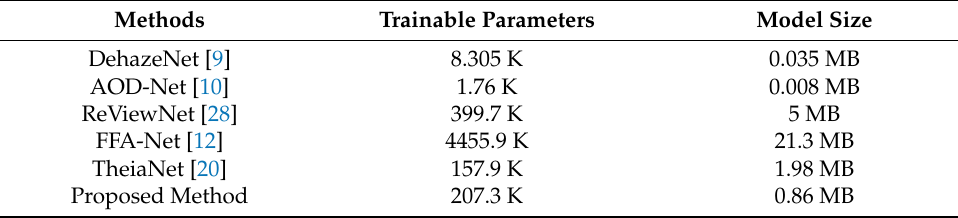
Table 2. Comparison of trainable parameters.